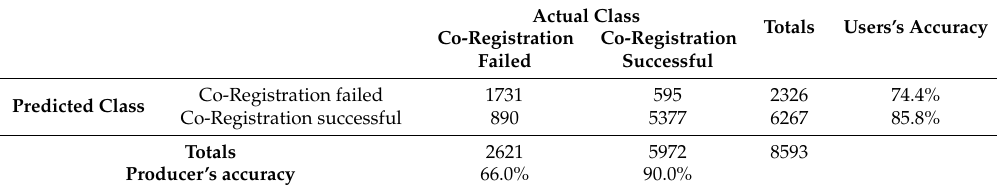
Table 5. Confusion matrix for co-registration using synthetic validation data.